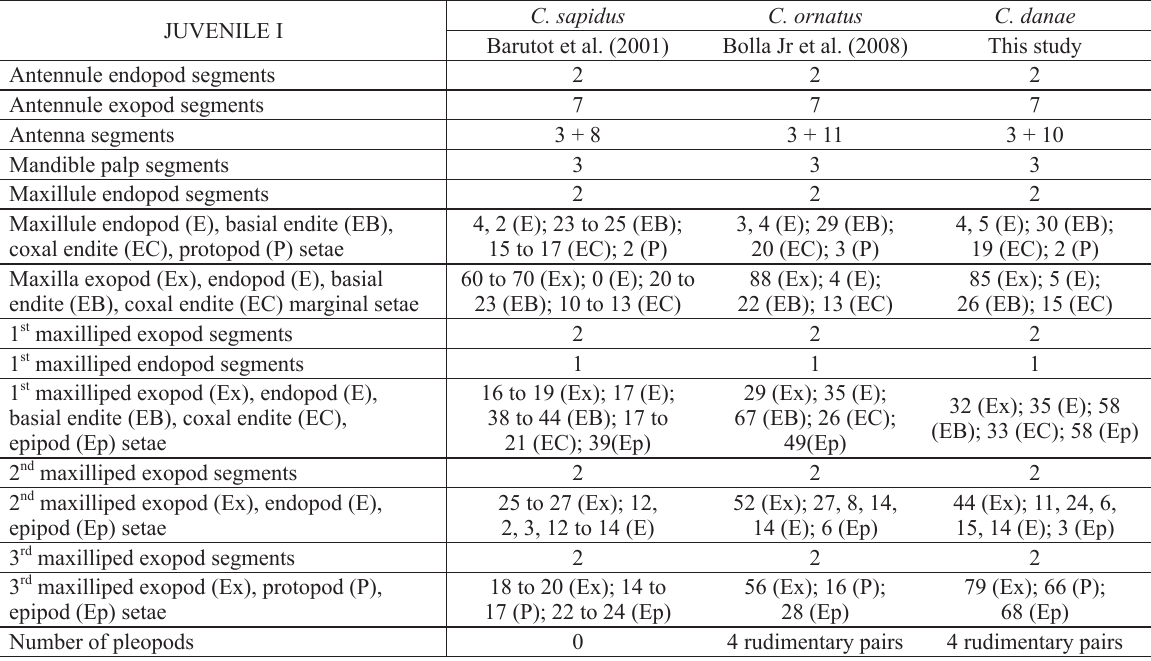
Diagnostic characters which allow the differentiation and identification of the first undifferentiated stage of the known species of the genus Callinectes with regards to juvenile